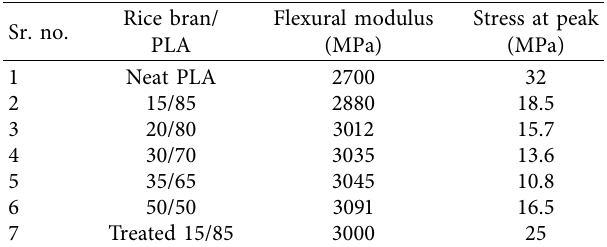
Table 3: Flexural test results for rice bran PLA composite. Sr. no.